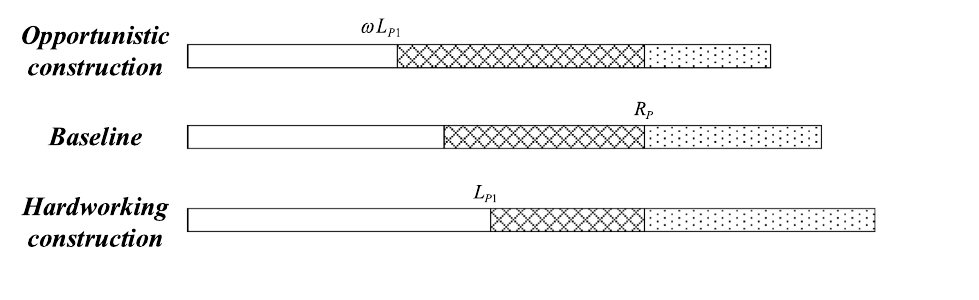
Figure 6. Main stakeholders of Sponge City PPP project.